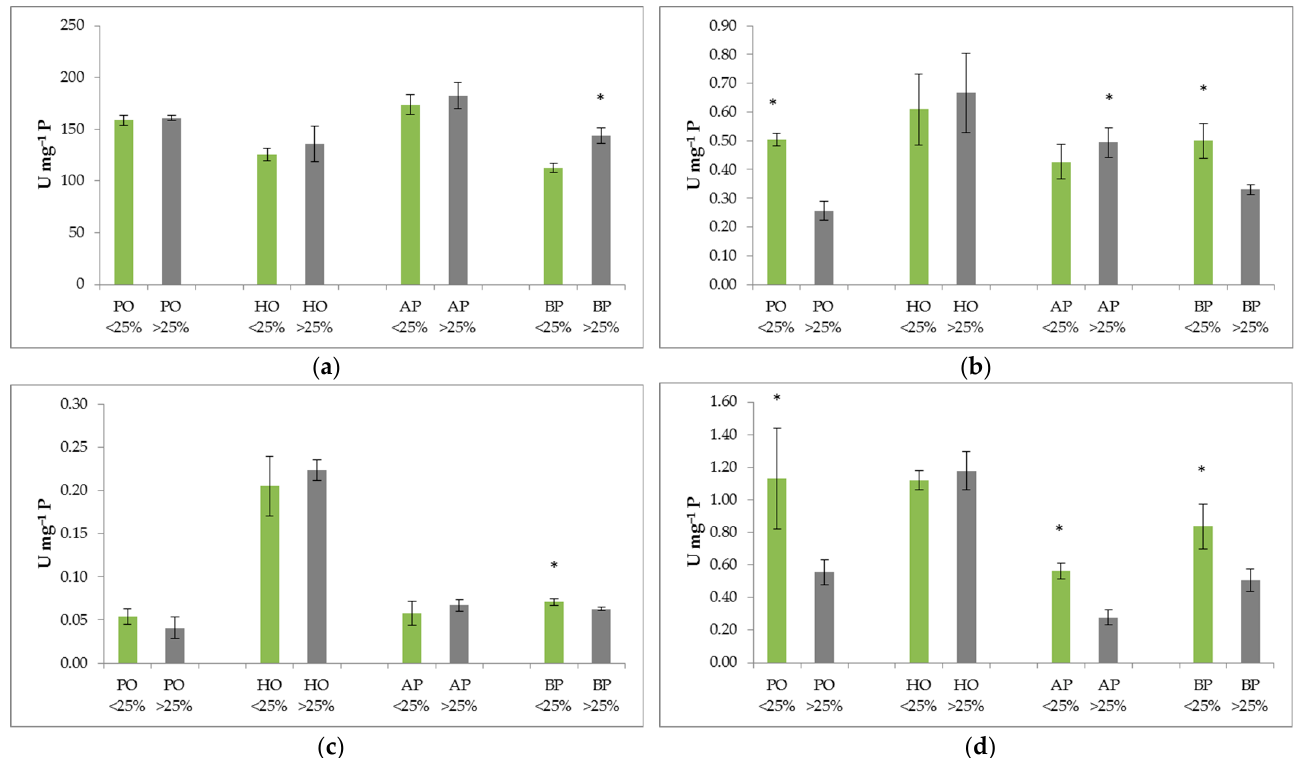
Figure 1. Activity of ( a ) superoxide dismutase (SOD), ( b ) catalase (CAT), ( c ) peroxidase (POD), and ( d ) ascorbate peroxidase (APX) in the leaves and needles of defoliated (defoliation of >25%, grey) and undefoliated (defoliation of ≤ 25%, green) pubescent oak (PO), holm oak (HO), Aleppo pine (AP), and black pine (BP) trees. Results are expressed as mean ± S. D. ( n = 3). Values marked with a star (*) show a statistically significant difference between defoliated and undefoliated trees for a given species according to the Student’s t -test (* p < 0.05).